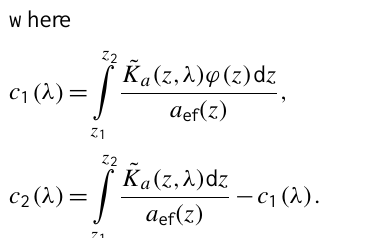
Fig. 3. The same as in Fig. 1c except the results at VZA equal to 75 degrees are also given (dashed lines).